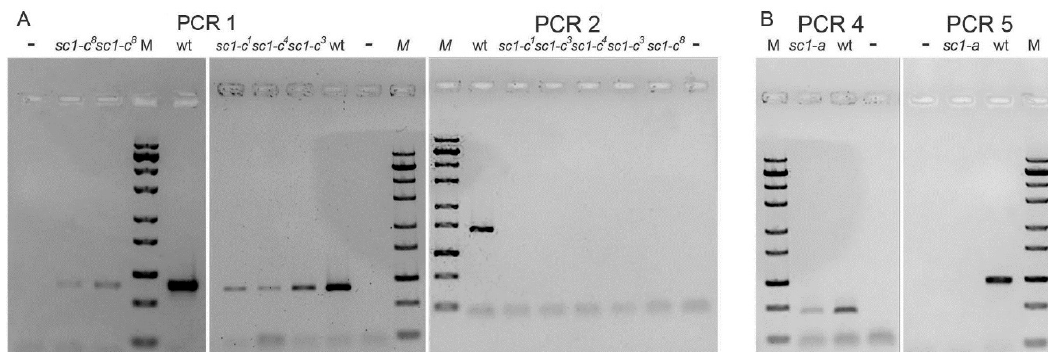
Figure 4. Localization of the breakage sites within MAC sca ff old 77 for screwy mutants. ( A ) Results of PCRs framing the chromosome breakage points in allelic mutants sc1-c . ( B ) Results of PCRs framing the chromosome breakage point in mutant sc1-a . PCR products are not obtained when sequence homologous to the downstream primer is absent (PCR2; PCR5). The products of these PCRs are always present in wild type 51 strain (wt). “–” stands for negative control. M is ZipRuler ™ Express DNA Ladder Set (Thermo Fisher, USA). For primers used in PCRs see Figure 2 (mapping) and Table S1 (sequences).